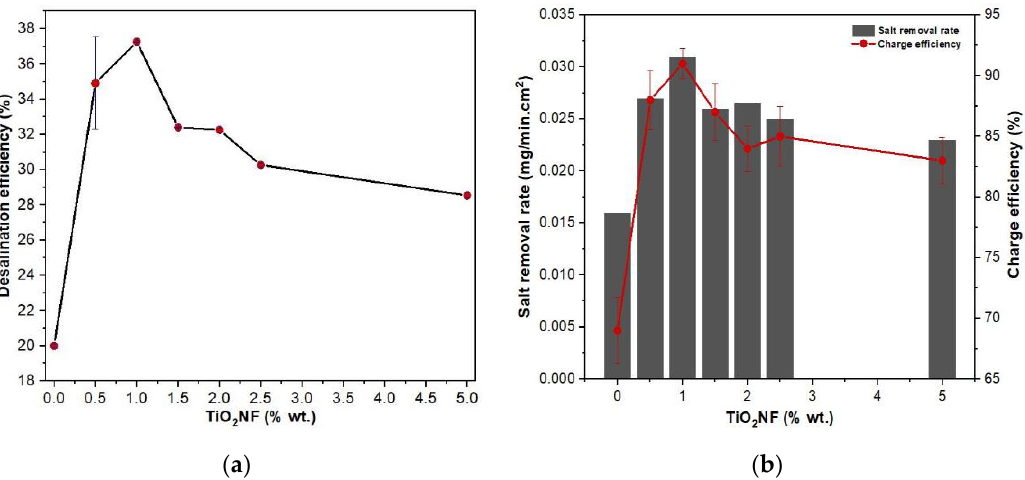
Figure 8. ( a ) Desalination efficiency; ( b ) salt removal rate and charge efficiency of AC and ACTiO 2 NF−x , where (x = 0.5, 1.0, 1.5, 2.0, 2.5, and 5.0 wt.% TiO 2 NF) respectively.